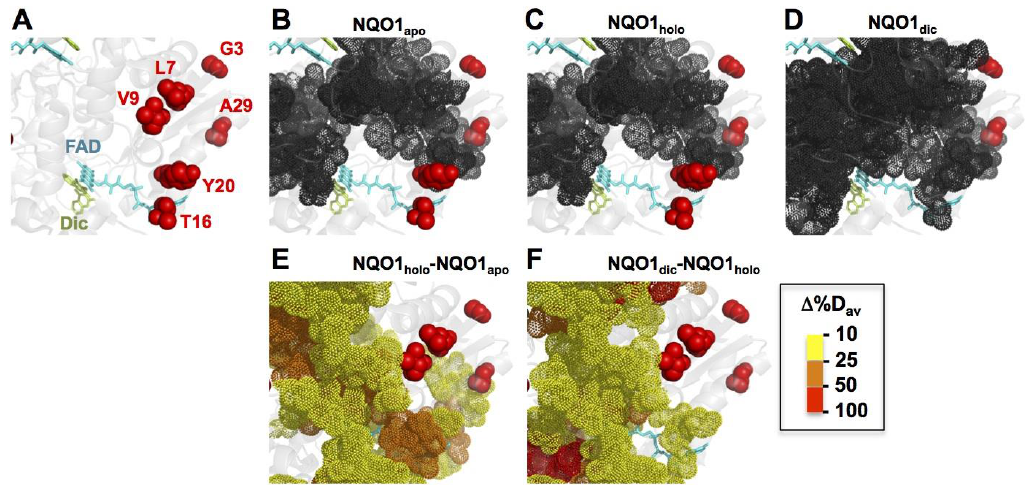
Figure 9. Location of mutated residues regarding local stability measurements by hydrogen/deuterium exchange (HDX). ( A ) Structural location of mutated residues regarding bound FAD and Dic. ( B – D ) Residues in dark grey/dot representation indicate those regions of the WT protein (NQO1 apo , NQO1 holo and NQO1 dic ) that are highly stable (<20% HDX after 3 h). ( E , F ) Residues in dot representation (see color scale) indicate those whose stability (as Δ%D av ) was increased between the two states (NQO1 holo vs. NQO1 apo and NQO1 dic vs. NQO1 holo ). Plots are generated using primary data from [90].